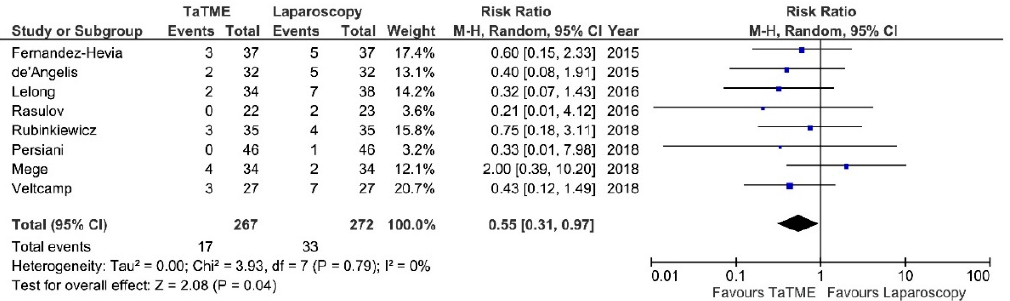
Figure 3. Major complications (Clavien-Dindo III–V). CI—Confidence Interval; df—degrees of freedom, M-H—Mantel-Haenszel test. WMD and RR are presented on the graphs as squares, and overall WMD and RR is presented as diamond.